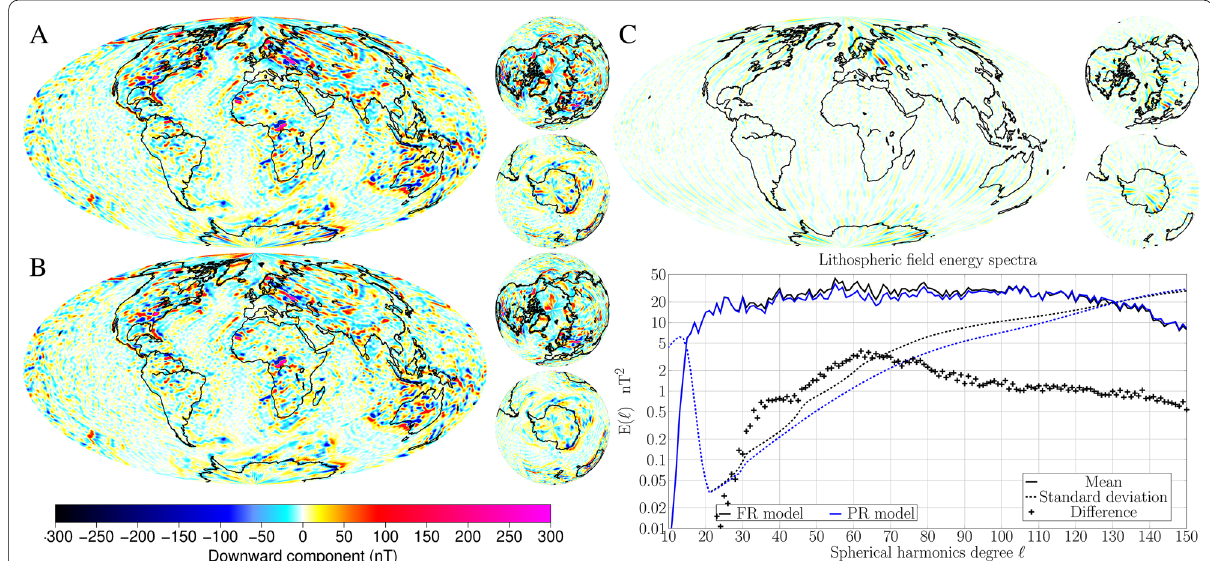
Fig. 6 Lithospheric field at the Earth’s surface expanded up to spherical harmonics degree ℓ = 150 . Left: mean downward component solution for the FR model estimated with full covariance information (top) and for the PR model estimated with variance only information from ℓ = 30 (bottom). Top right: difference between FR and PR models mean downward components. Bottom right: energy spectra of the means (solid lines), the standard deviations (dashed lines) and the difference (crosses) between the FR model (black lines) and PR model (blue